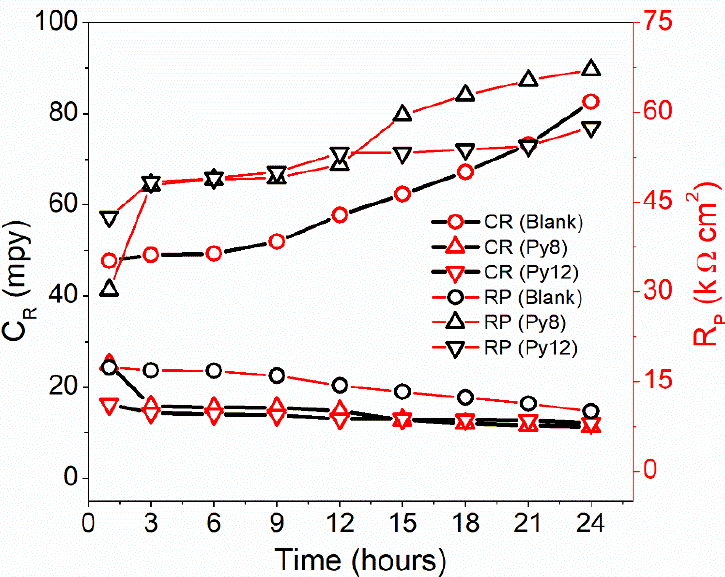
Figure 4. Plot of corrosion rate ( C R ) and polarization resistance ( R P ) versus time obtained for EN3B mild steel in the absence and presence of 5 mM Py8 and Py12 in 3.5% NaCl solution, pH = 1.5 up to 24 h. Table 3. Linear Polarization parameters obtained for EN3B mild steel in the absence and presence